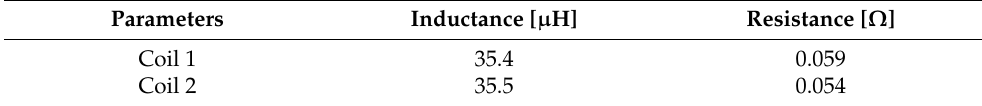
Figure 19. Fabricated actual WPT coils. Table 9. Measured inductance and resistance of the WPT coils.